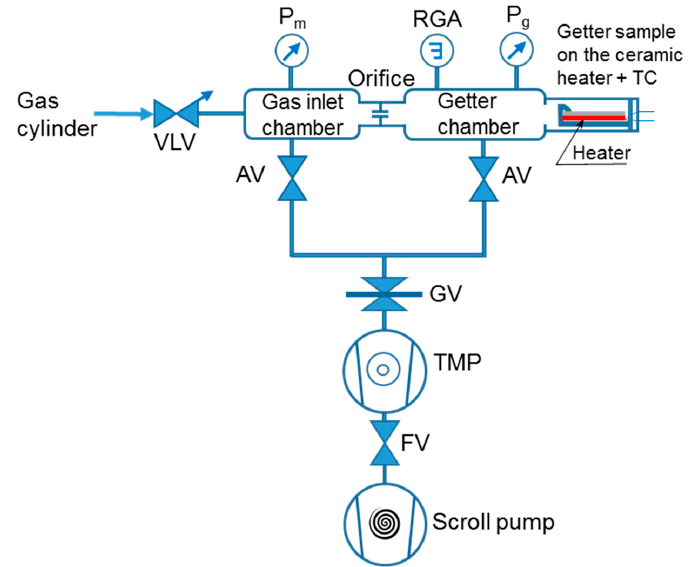
Figure 1. Schematic diagram of the getter test system. P m , P g : Pressure gauge, AV: Angle valve, GV: Gate valve, VLV: Variable leak valve, TMP: Turbo molecular pump, FV: Fore-line valve, RGA: Residual gas analyzer (device dismantled for total pressure measurements).